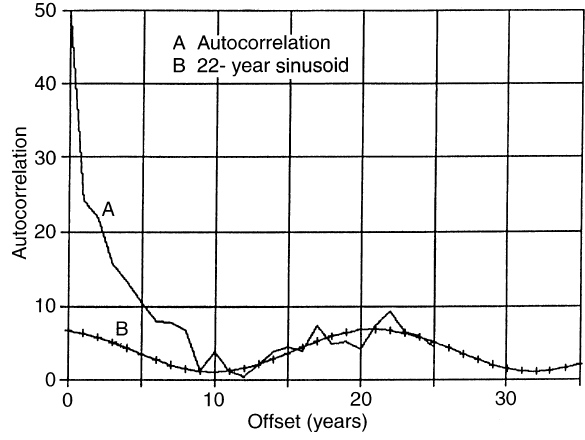
Fig. 15. Global volcanism (annual and long-term) Fig. 16. Volcanism and ‘‘groomed’’ solar signal 1